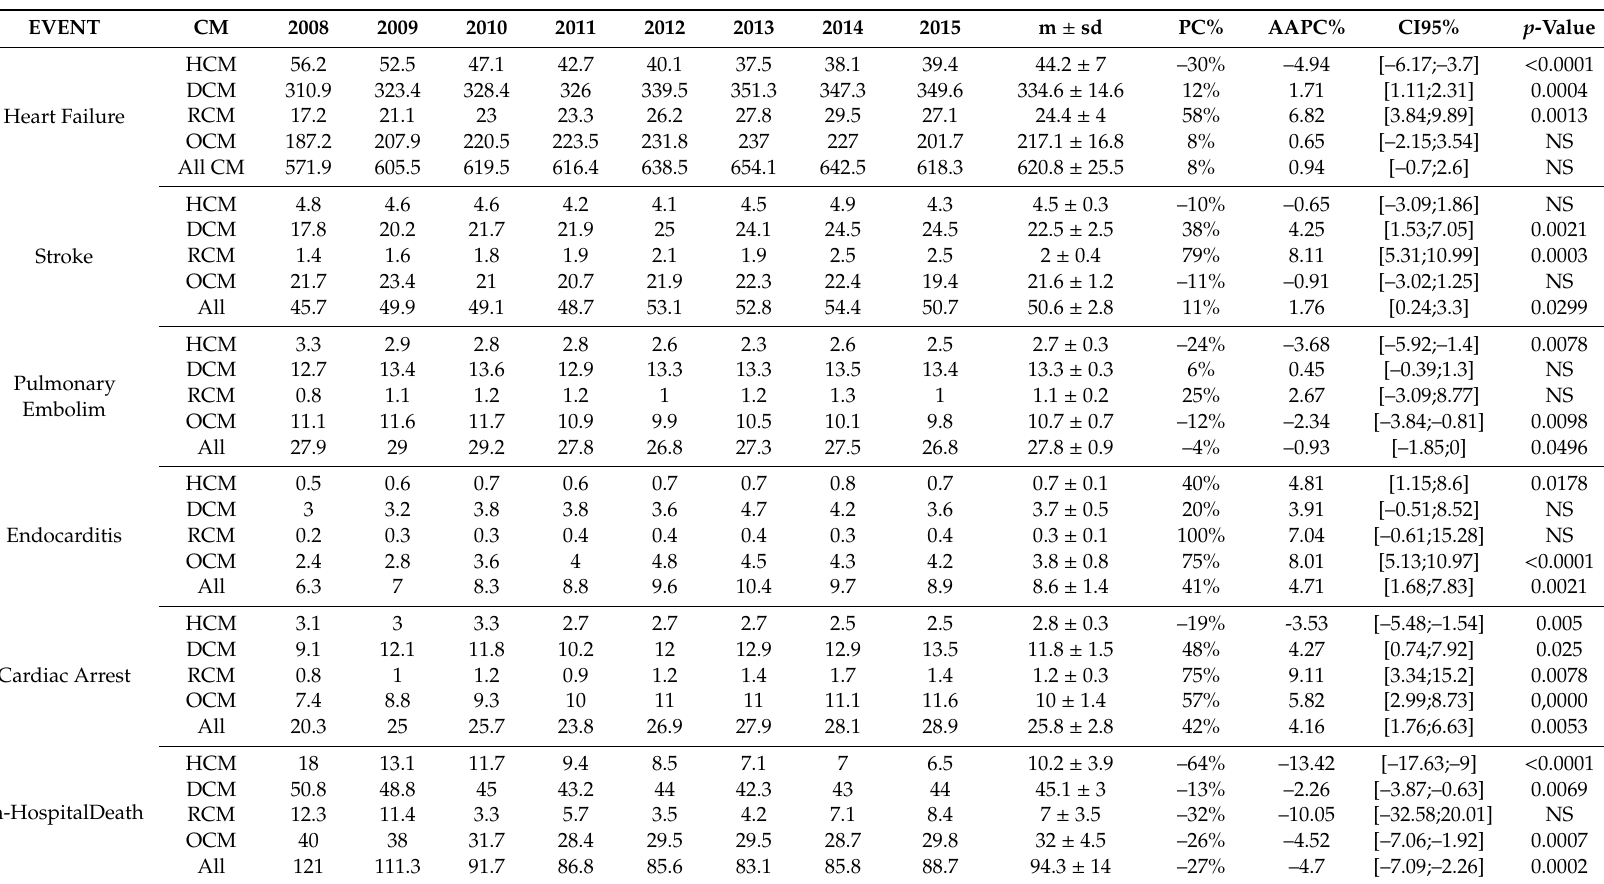
Table 2. Temporal variations of inpatient prevalence of events (per million inhabitants), by type of event and cardiomyopathy, over the period 2008–2015. EVENT